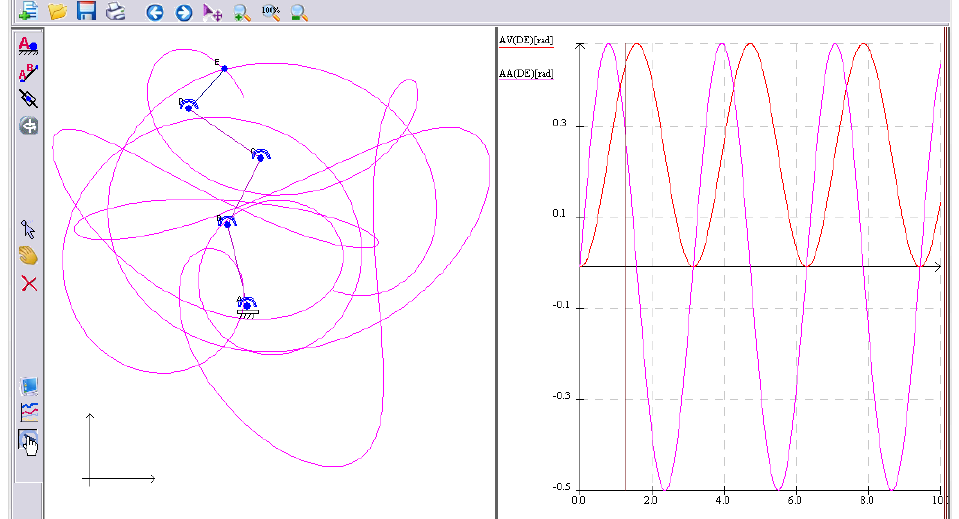
Figure 10. Simulation of a manipulator with four trainers.